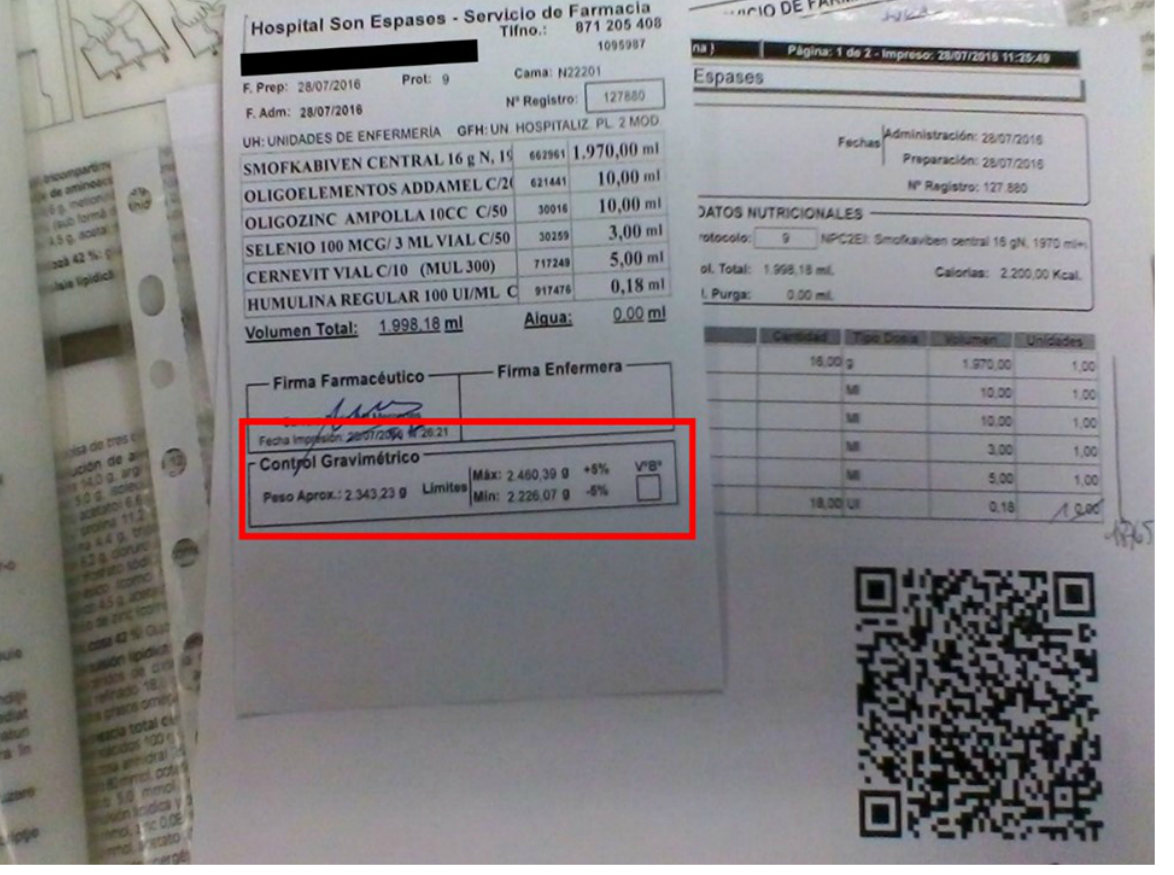
Figure 2. Label on a bag of parenteral nutrition, including data from the gravimetric